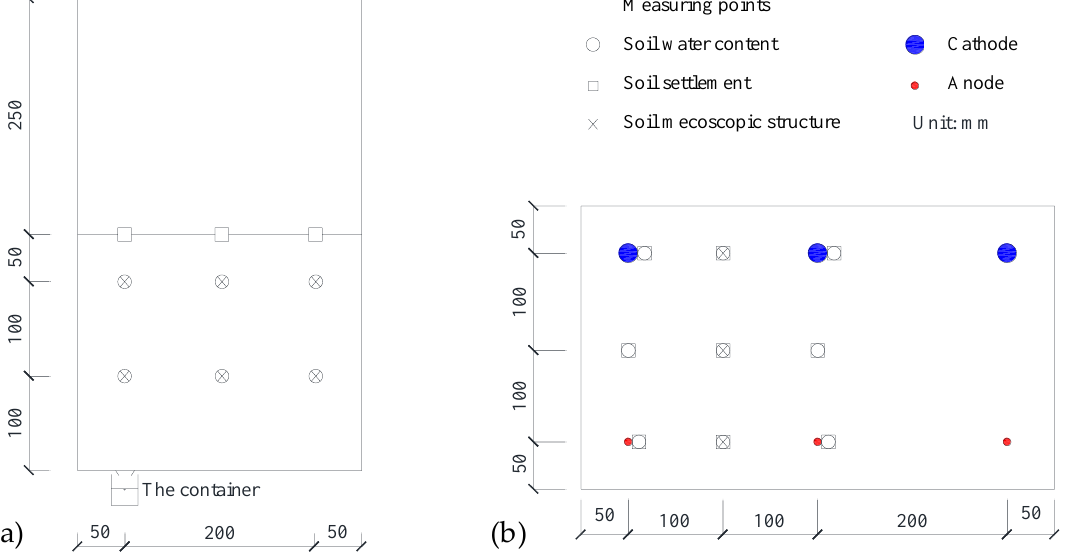
Figure 3. Layout of the measuring points for soil water content, settlement and mesoscopic structure: ( a ) The sectional view; ( b ) The plan view.